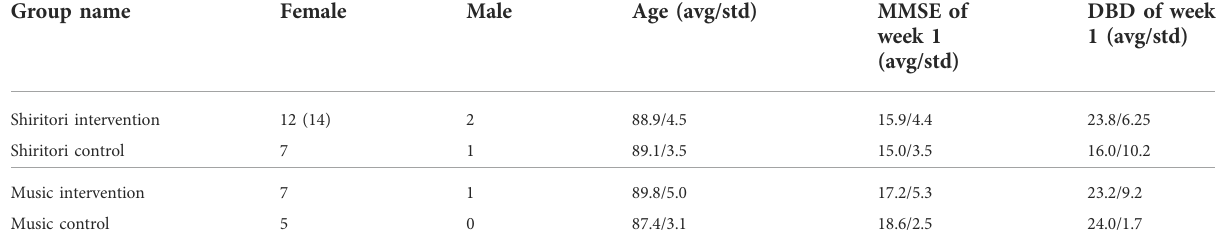
TABLE 2 Statistics of the experiment ’ s participants. The value of the female column in parentheses is the number of originally assigned